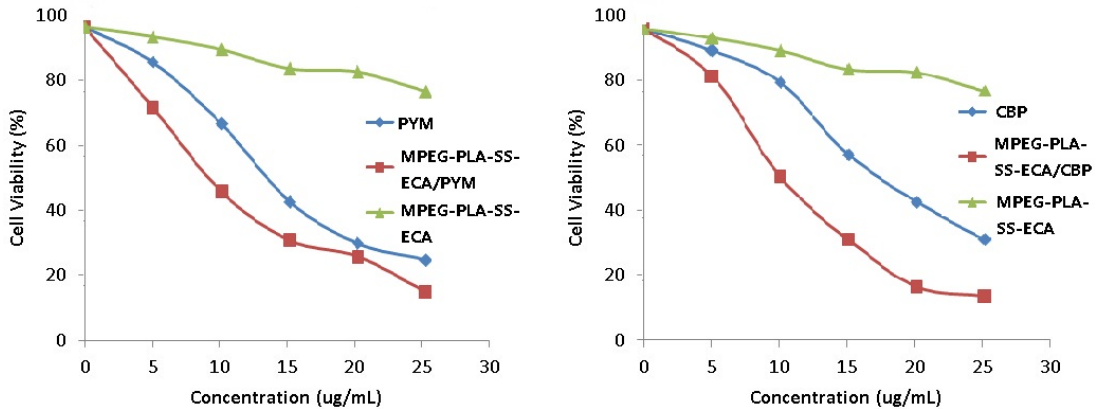
Figure 5. ( a ) SCC15/PYM cells were treated with PYM and MPEG–PLA–SS–ECA/PYM,